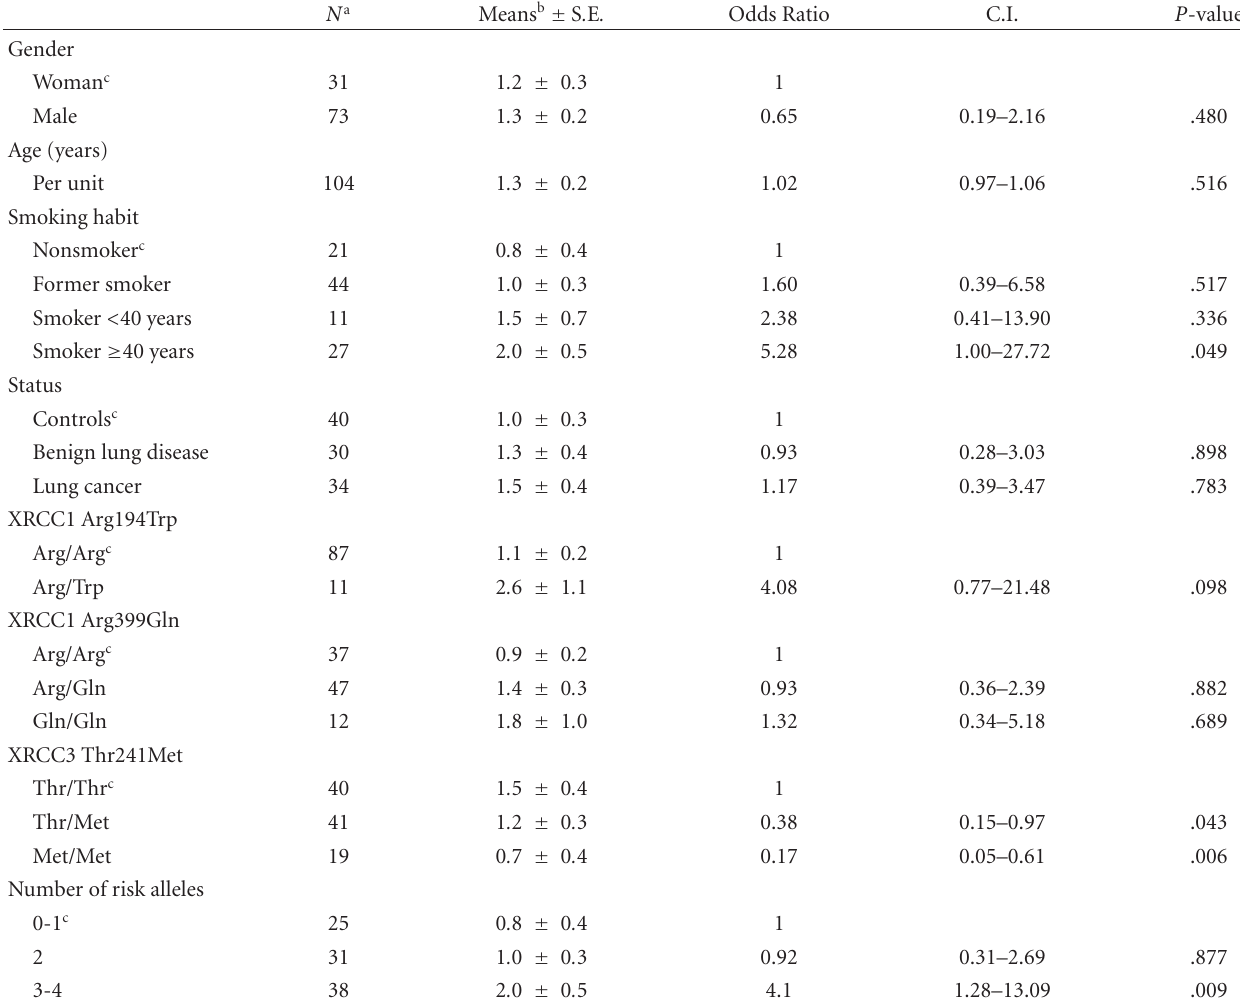
Table 1: Means of DNA adducts ± standard error (SE) for di ff erent variables considered in the study plus the parameter estimates of the multivariate regression